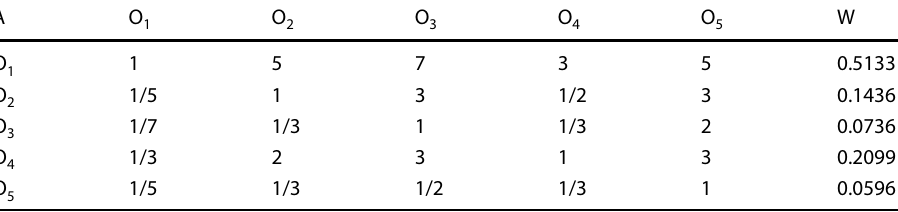
Table 6 Target layer alignment criteria into judgment matrix